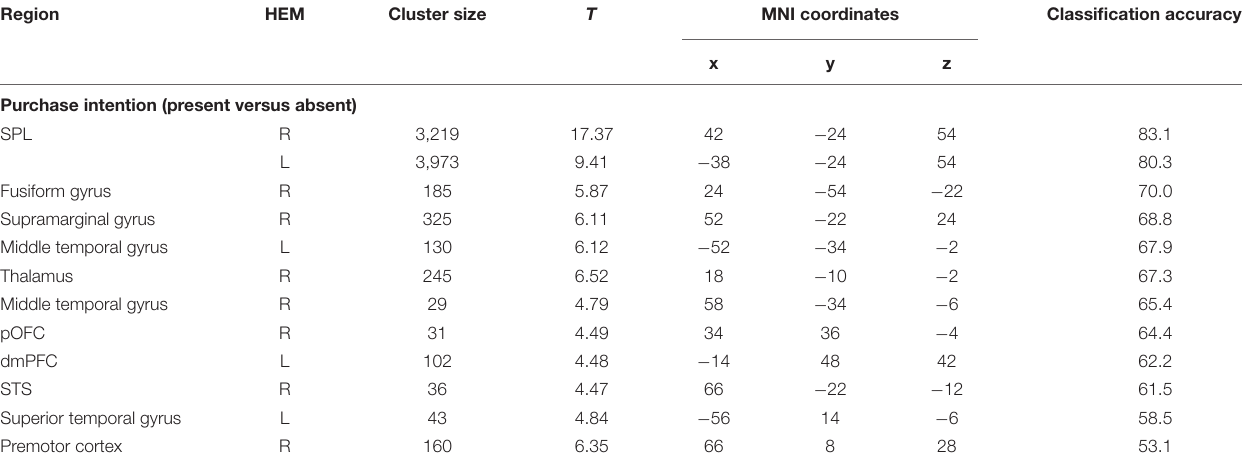
TABLE 4 | Multivariate pattern analysis results of purchase intention during the fit evaluation phase in the order of highest to lowest classification accuracy.